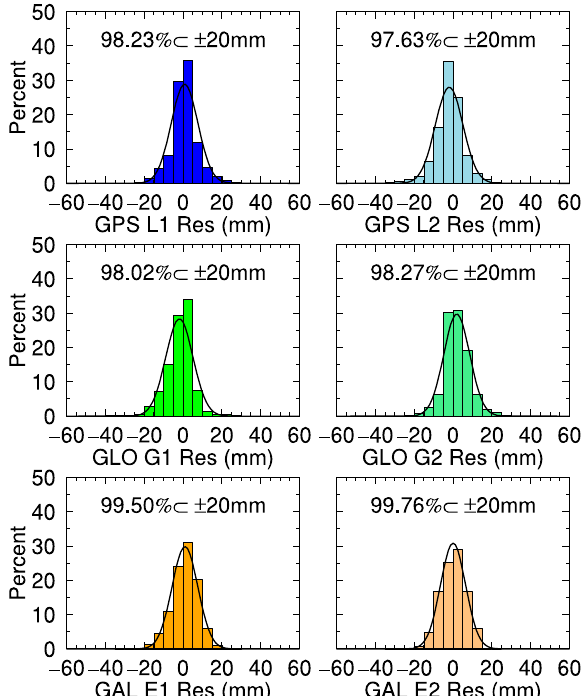
Figure 11. Distribution histogram of residuals for SHM2-SHM1.